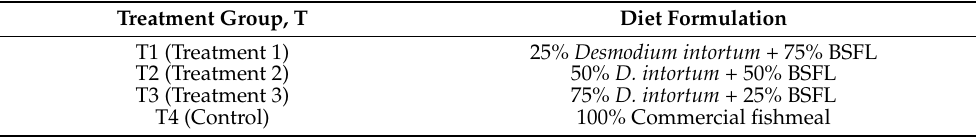
Table 1. Summary of diet formulations into four treatments using combinations of varying proportions of BSFL (Black Soldier Fly larvae) and Desmodium intortum in place of the conventional fishmeal diet. Treatment Group, T